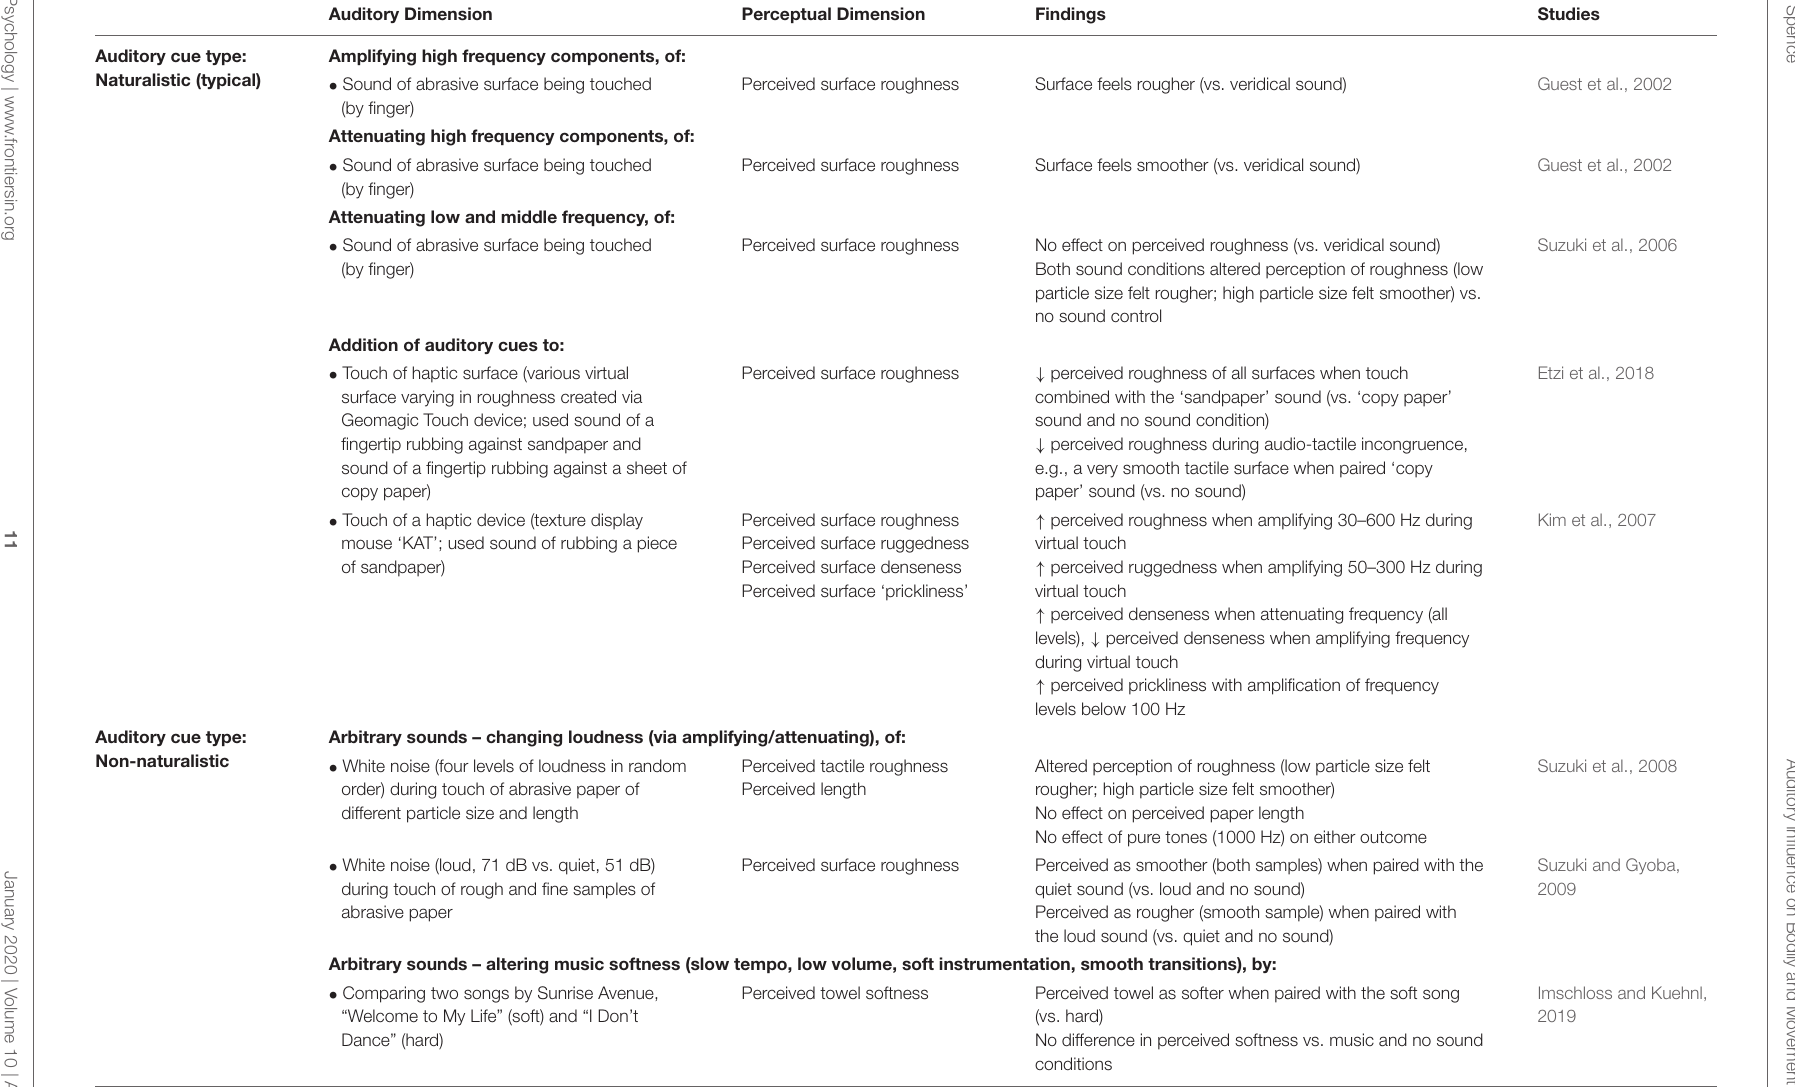
TABLE 3 | Summary of the effects of non-veridical auditory cues on movement-related touch: surface texture